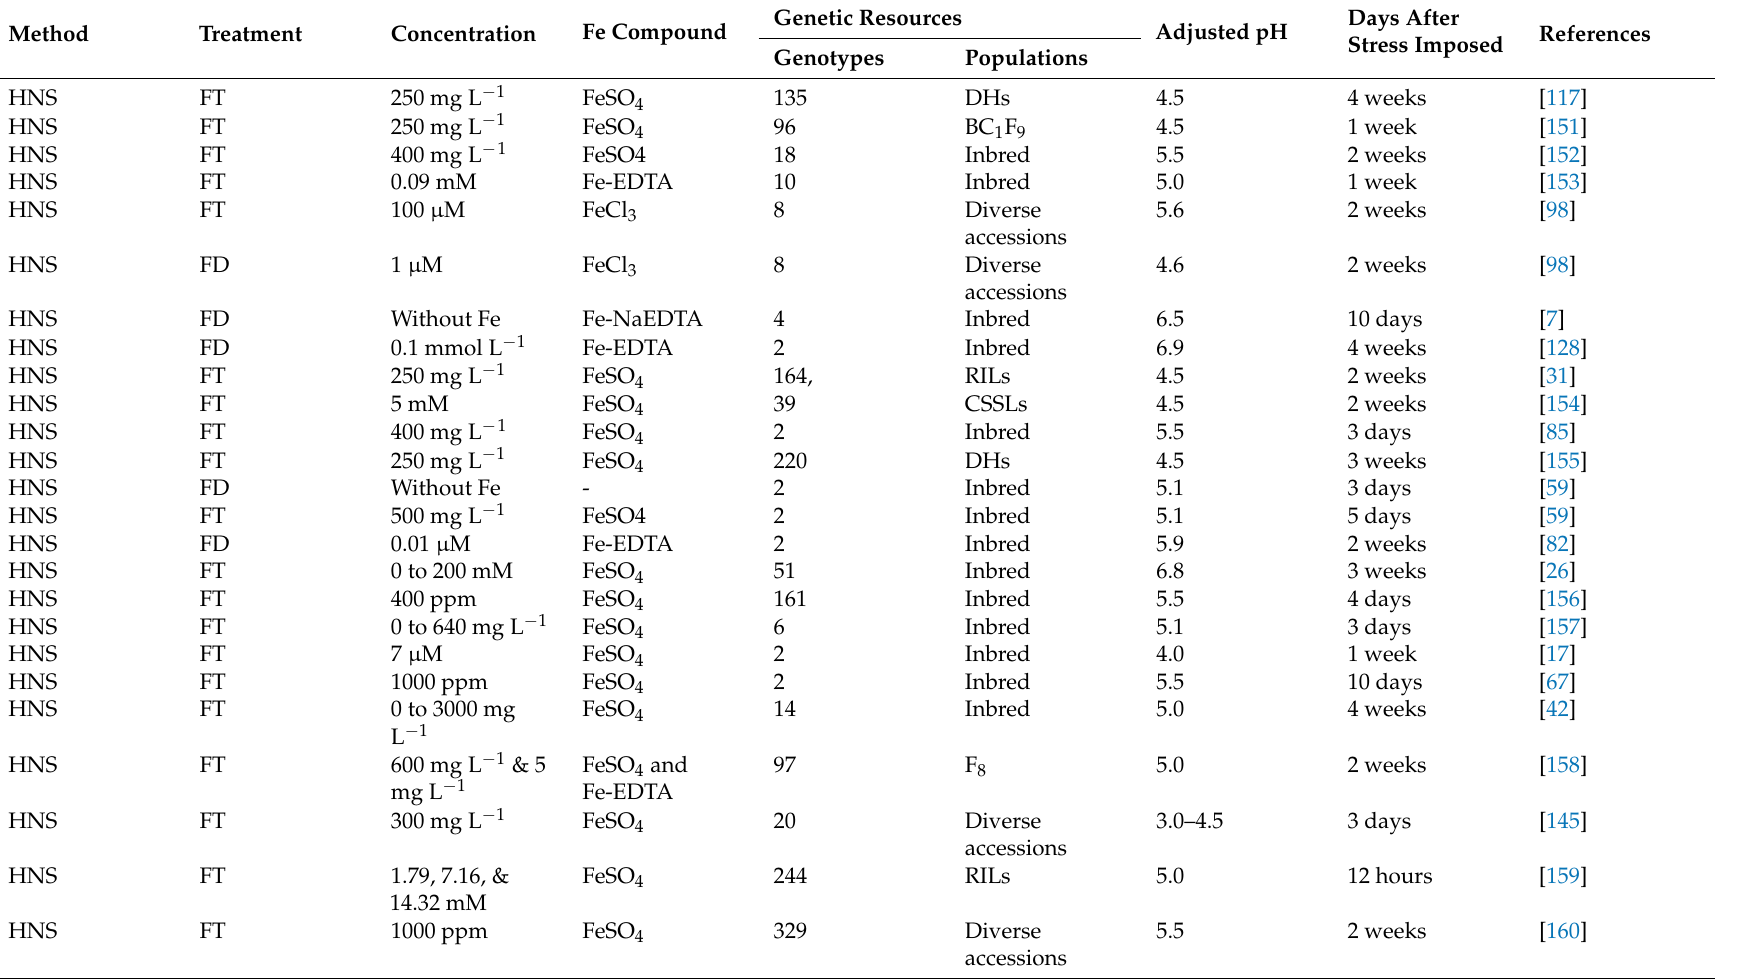
Table 1. Different methodologies used to screen germplasm against FD and FT in